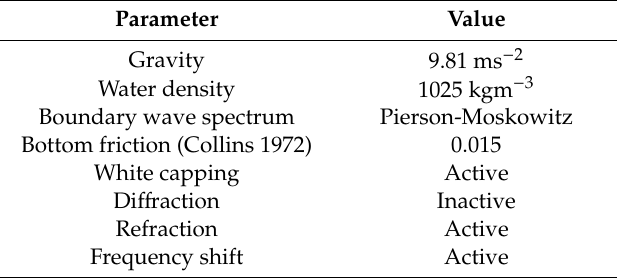
Table 1. Calibration parameters for SWAN model.